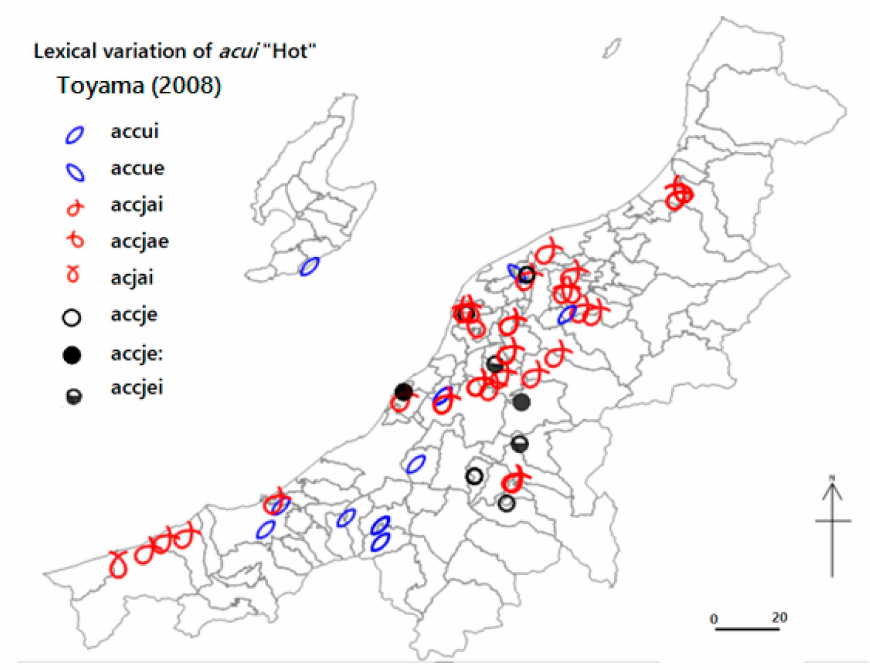
Figure 11. Lexical variation of atsui “hot” in Niigata: Toyama